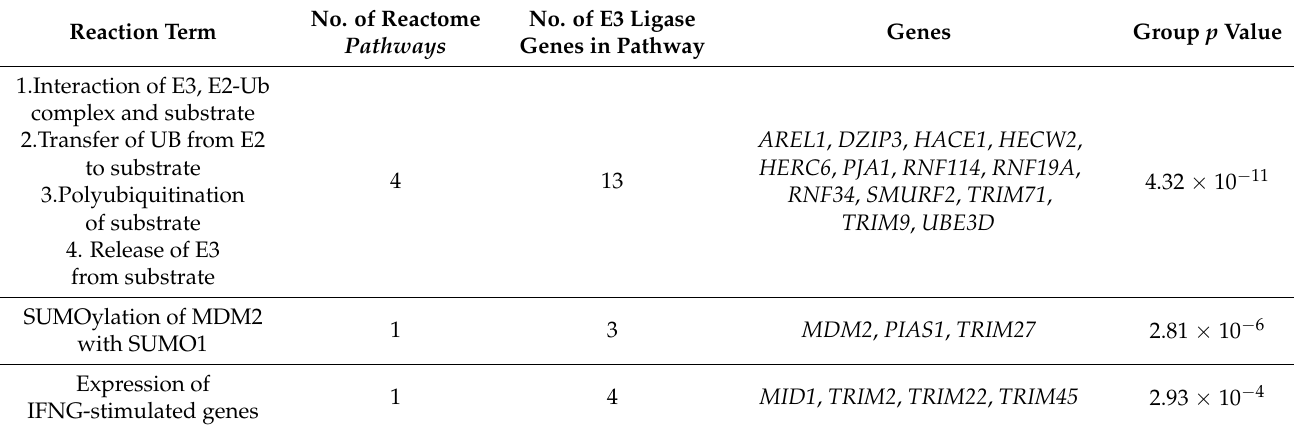
Table 5. Main interactome Reactions over-represented by E3 ligase genes of Figure